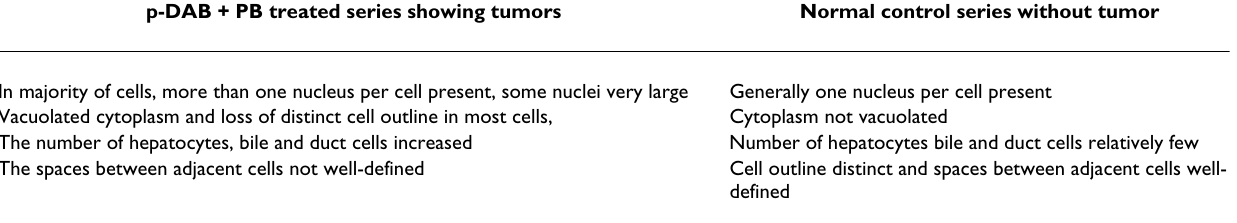
Table 1: Showing some salient changes in liver histology of p-DAB+PB treated mice (showing tumors) as compared to untreated controls p-DAB + PB treated series showing